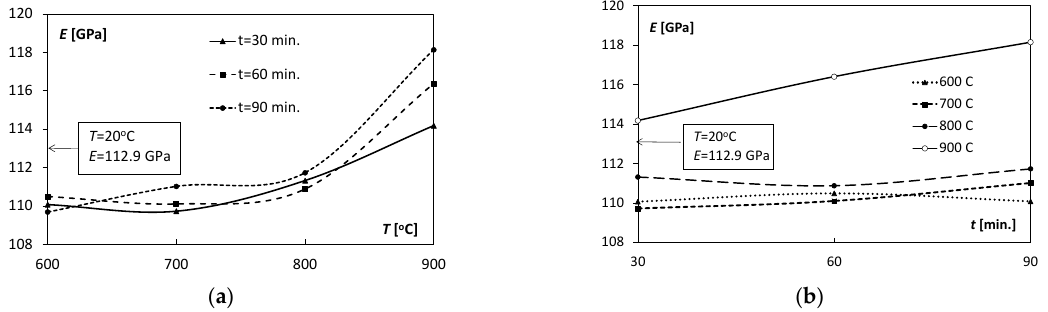
Figure 2. Variations of values of Young’s modulus E of the Ti/Cu bimetal dependent on: ( a ) temperature T , ( b ) annealing time t .